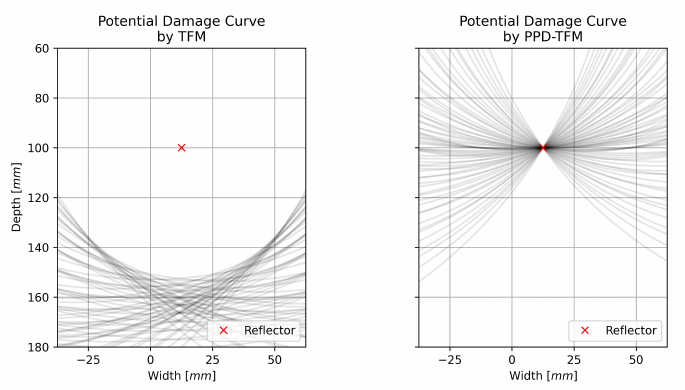
Figure 5. Potential damage curve for TFM ( left ) and PPD-TFM ( right